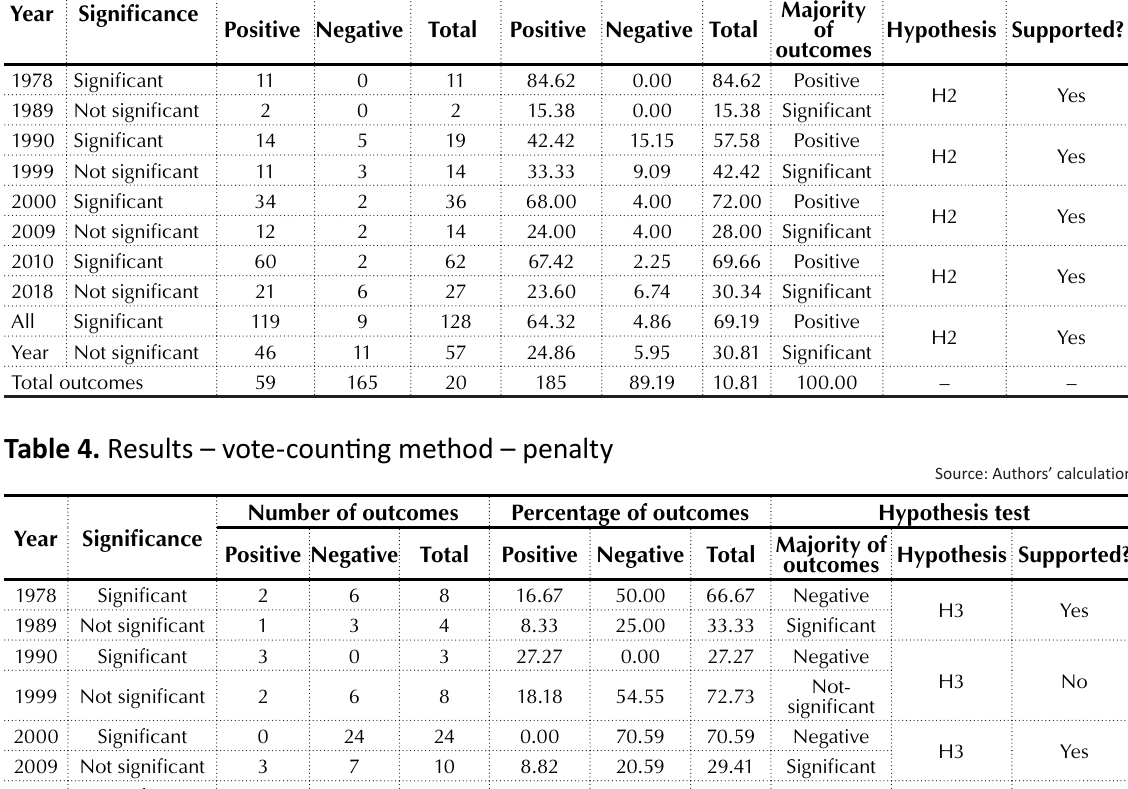
Source: Authors’ calculation.